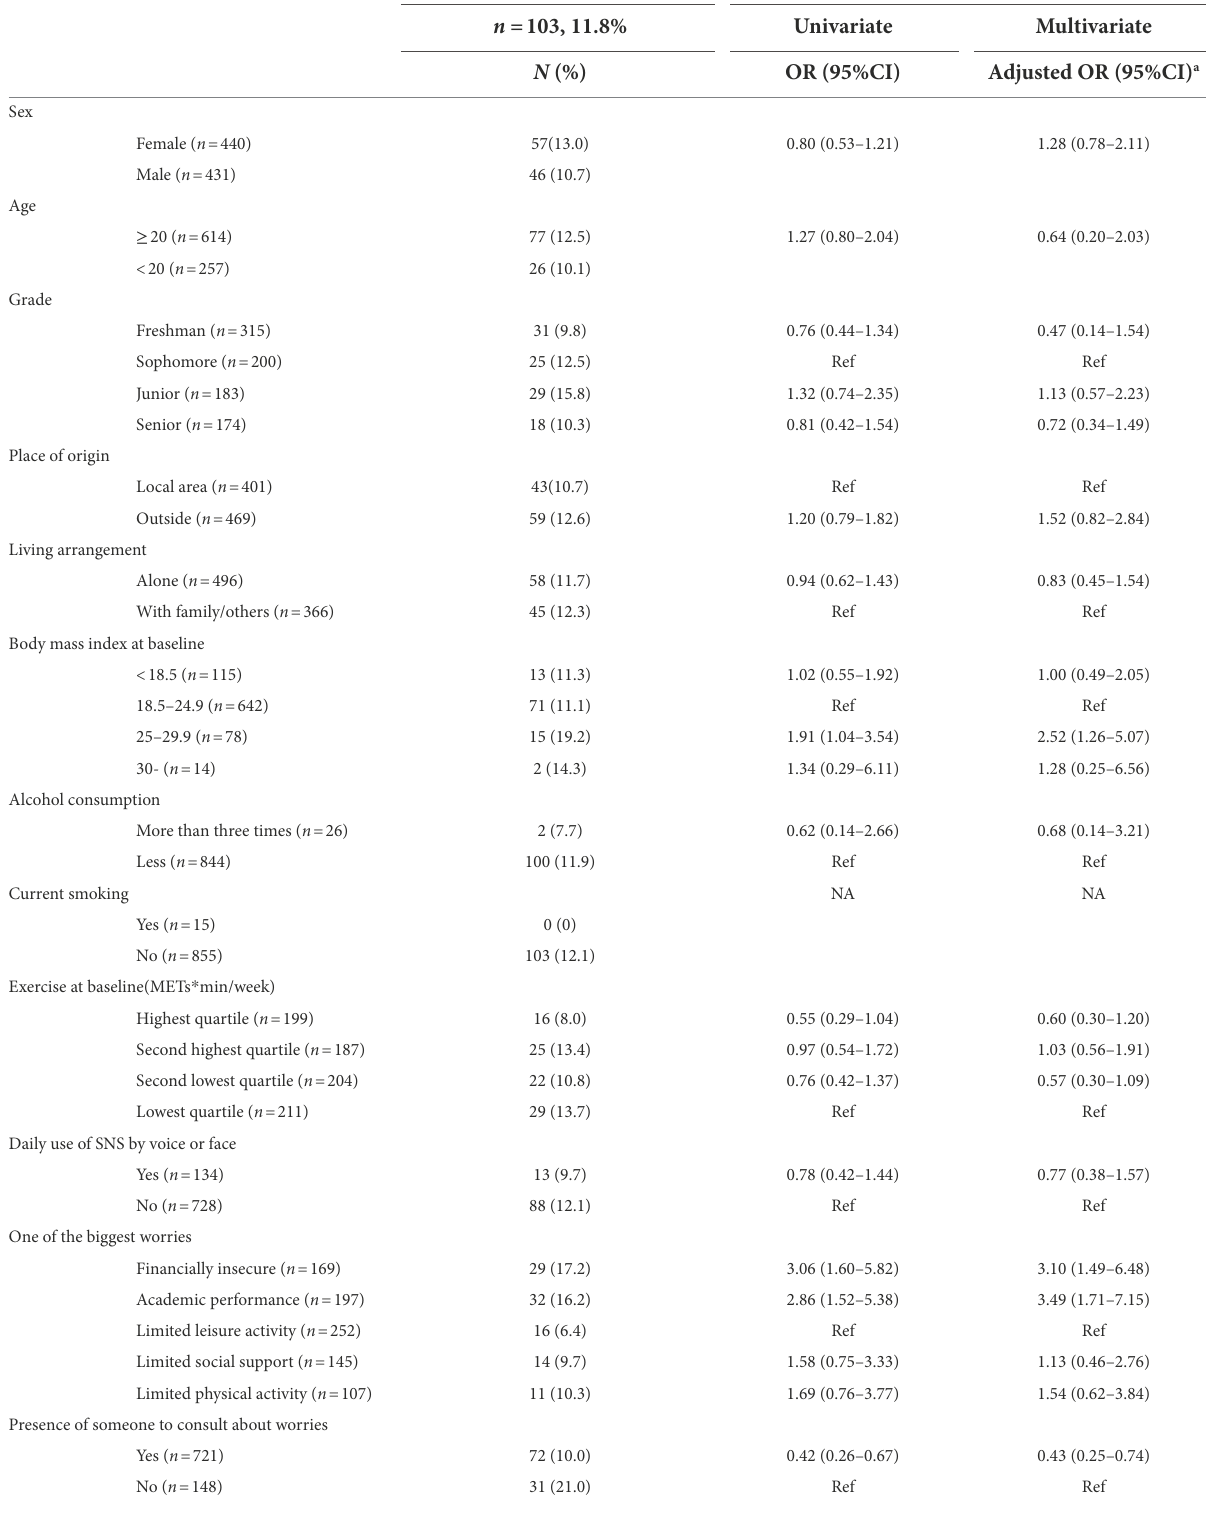
TABLE 3 Factors associated with new onset of moderate depression based on PHQ-9 score ≥ 10 at T 2 (in March–May 2021): n =